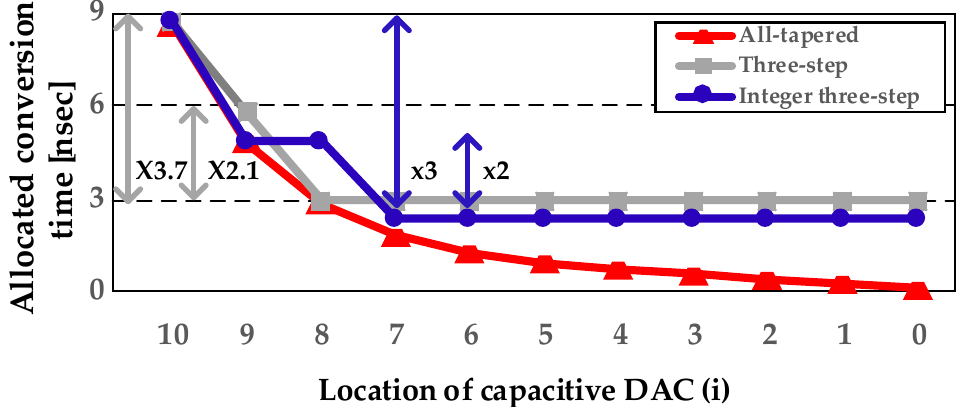
Figure 5. Delay time with three - step and integer three - step technique when R ref = 400 Ω